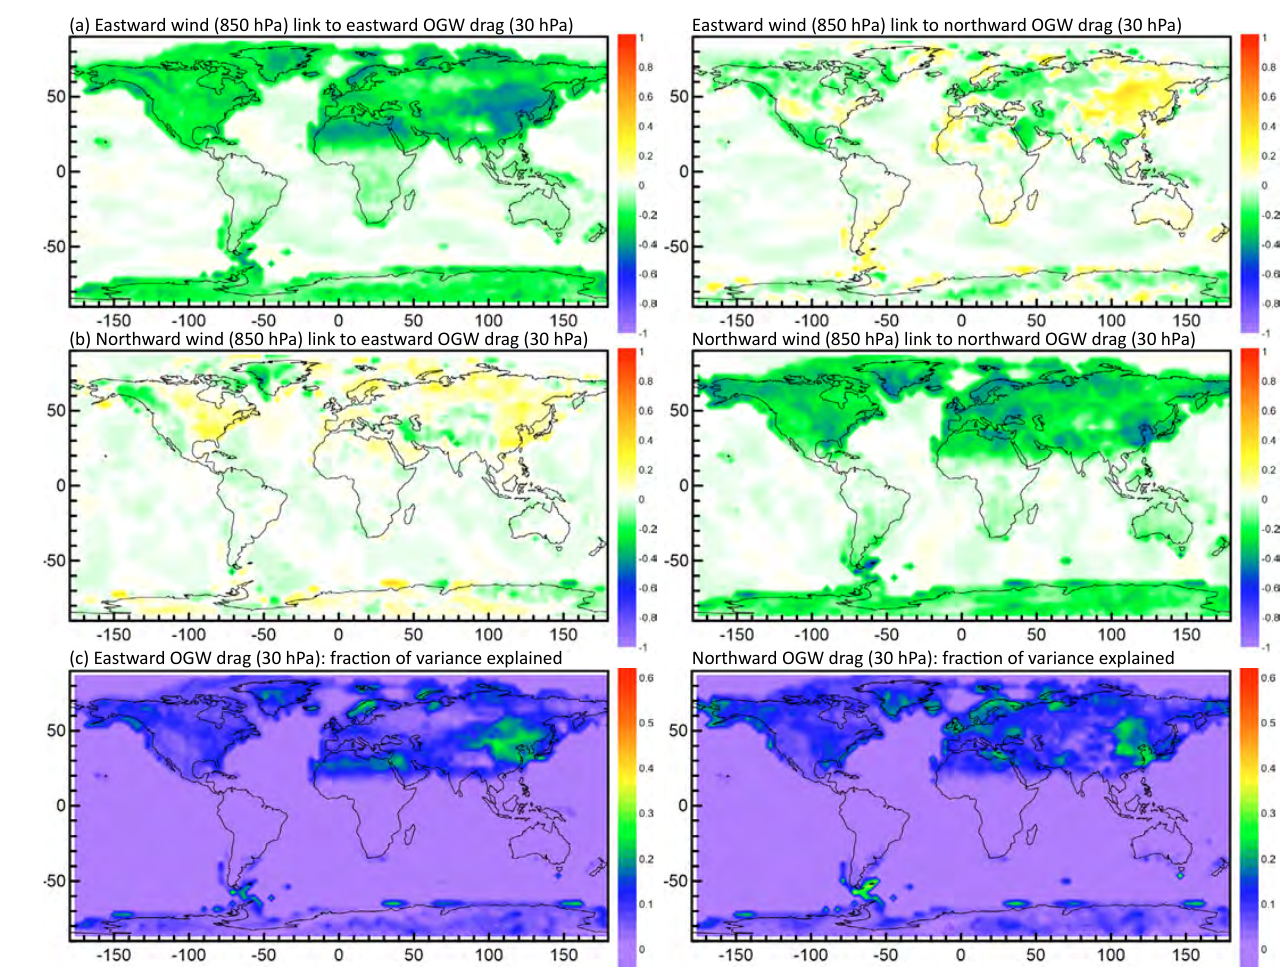
Figure 8. (a, b) Standardized regression coefficients between orographic gravity wave drag at the 30hPa level (predictand) and eastward and northward wind components at the 850hPa level (predictors), during the DJF season. (c) Coefficient of determination, i.e., the fraction of total variance of OGWD explained through the regression mappings by both components of wind at the 850hPa level. Analysis period: 1979–2010, daily data, DJF